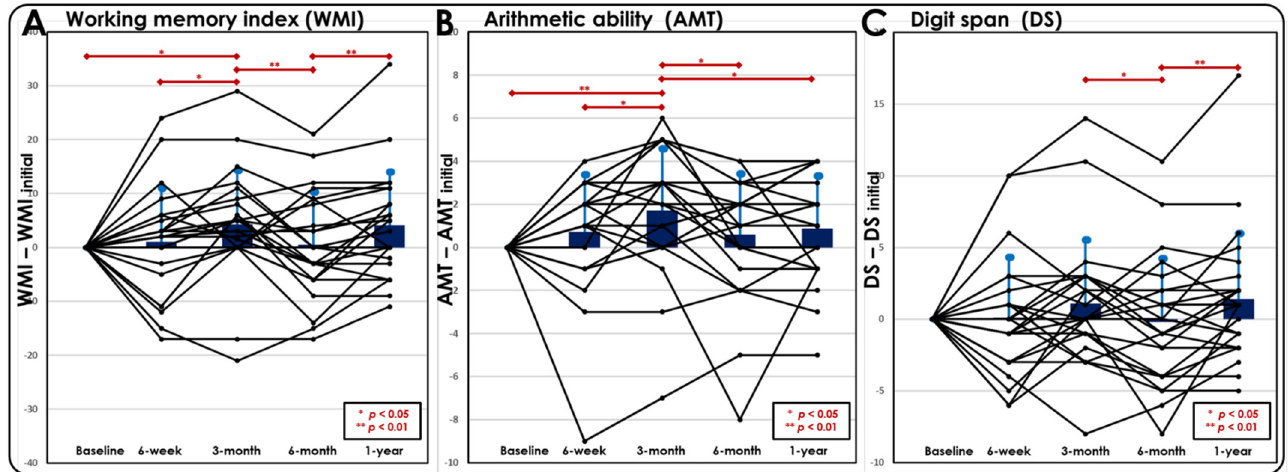
Figure 2. Postconcussive cognitive changes over time between the baseline and follow-up. Dynamic individual patient trajectories of ( A ) the WMI, ( B ) AMT, and ( C ) DS at each time point. The trajectories were normalized by subtracting the baseline measurements for better visualization. Patients exhibited significant recovery during the 3-month follow-up but worsened again from 3 months to 6 months or even at the 1-year follow-up. Compared with the baseline measurements, roughly half of the patients with a mTBI displayed reduced cognitive function after 1 year. (* p < 0.05, ** p <